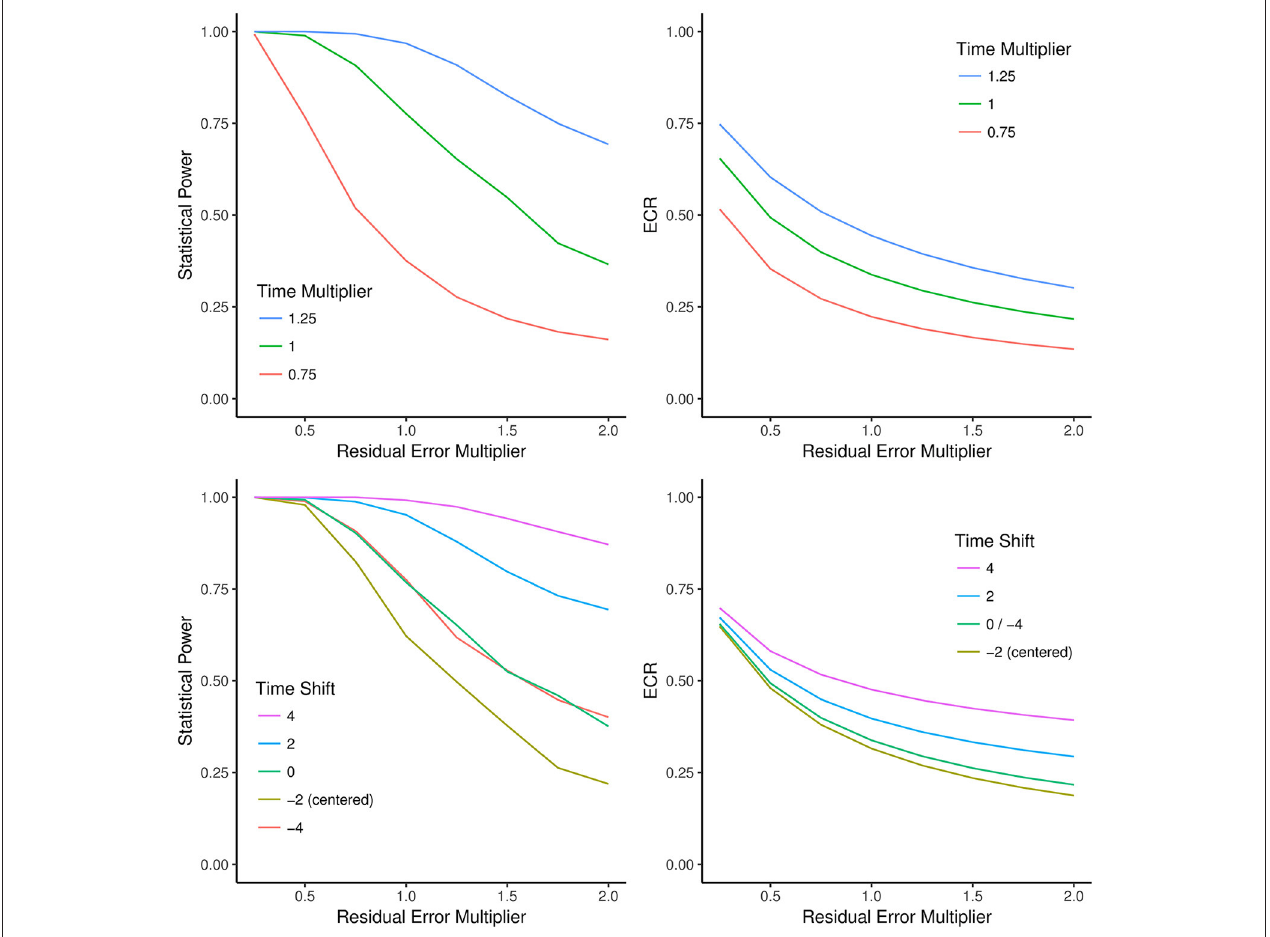
FIGURE 4 | The effects of shifting, prolonging, or compressing the study duration on statistical power and effective curve reliability (ECR). Top left : Monte Carlo simulation of the effect of decreasing or increasing residual error variance (x-axis) or shortening/prolonging total study duration (blue, green, and red lines) on statistical power (y-axis). Top right : The effect of decreasing or increasing residual error variance (x-axis) or shortening/prolonging total study duration (blue, green, and red lines) on ECR (y-axis). ECR traces the same shapes of decreases in statistical power as observed in the top left panel. Bottom left : Monte Carlo simulation of the effect of shifting the measurement time points by factor ( − 4, − 2, 0, 2, 4; colored lines) and changing residual error variance (x-axis) on statistical power (y-axis). Note that anchoring the intercept at the first or last measurement has identical power. Lowest power is achieved with a centered design. Bottom right: The effect of shifting the measurement time points by factors ( − 4, − 2, 0, 2, 4; colored lines) and changing residual error variance (x-axis) on ECR (y-axis). Note that the green line represents both the original design (shift: 0) and a design with intercept variance anchored at the last measurement (shift: − 4), both of which empirically have identical power whereas the centered design has lowest ECR and power. As shown in Equation (11), for all variations in time sampling, GRR yields the values corresponding to the ECR of the time-centered design (yellow line; t = − 2), and thus differential power because time shifts are not reflected in